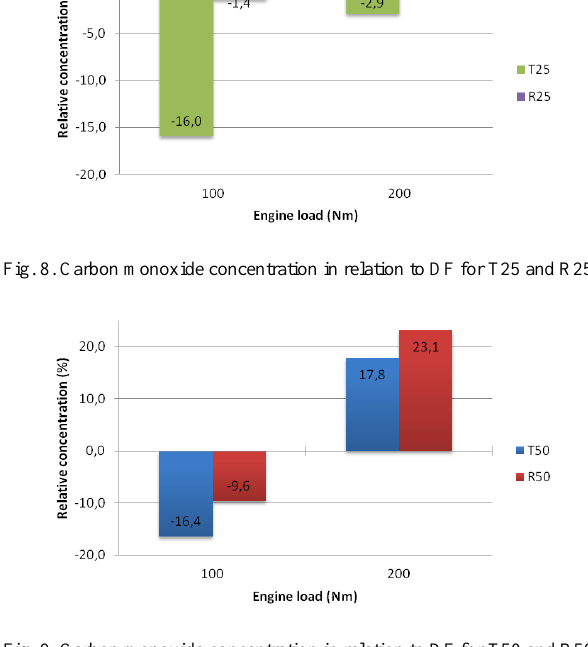
Fig. 9. Carbon monoxide concentration in relation to DF for T50 and